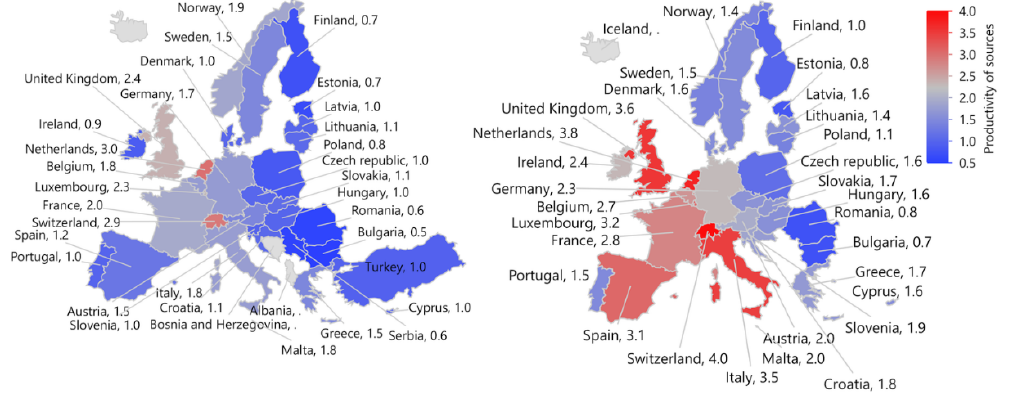
Figure 1. Cartographer—resources productivity in 2006 and 2016.